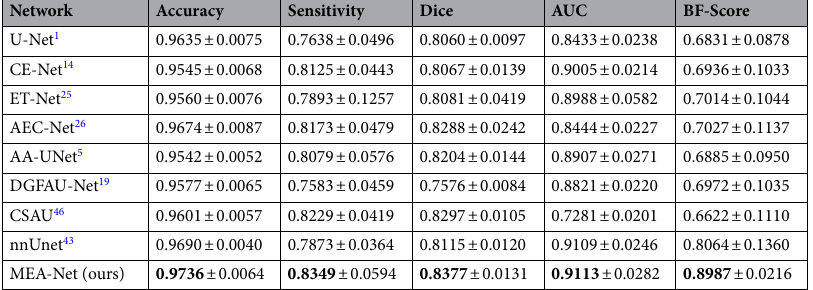
Table 2. Performance comparison on retinal vessel image segmentation (mean ± standard deviation). Significant values are in bold.